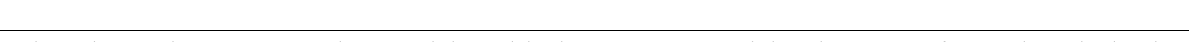
Fig. 1 Advanced maternal age impacts on embryonic and placental development. a Gross morphological appearance of E11.5 embryos developed in young (8 – 12 weeks old) and aged (42 – 54 weeks old) C57BL/6 females. Each row depicts one entire litter. Scale bars : 1 mm. b Histological analysis by H&E staining and by in situ hybridisation for the trophoblast giant cell marker Prl2c2 ( Plf ) of placentas associated with conceptuses developed in aged females. The top row depicts a normally developed embryo that is associated with a grossly normal placenta. The four rows below depict embryos with varying degrees of developmental retardation and morphological defects such as a failure of neural tube closure ( arrowhead ). The placentas associated with these embryos are also defective, insofar as the trophoblast portion is severely under-developed (the dotted line indicates the boundary between the fetal trophoblast compartment and the maternal decidua) or the main direction of placentation is off-centre (arrow). Scale bars : 1 mm. c RT-qPCR analysis of placentas developed in young control ( “ Y ” , n = 3) and aged ( “ A ” ) females. Conceptuses developed in aged females were divided into those that appeared grossly normal ( “ An ” ; n = 6) or abnormal ( “ Aa ” ; n = 6). Markers used represent trophoblast stem cell genes Eomes and Esrrb , markers of the so-called intermediate trophoblast (as found in the ectoplacental cone) or spongiotrophoblast (SpTr) Tpbpa and trophoblast giant cells Prl2c2 , and placental labyrinth expressed genes Synb and Ctsq . Data are displayed as mean ± S.E.M. * p < 0.05; ** p < 0.01; *** p < 0.001 (ANOVA with Holm-Bonferroni ’ s post-hoc test). d Diagram of the main trophoblast differentiation defects frequently observed in aged females. Green shading indicates compartments that are relatively over-represented, whereas red shading depicts major differentiation routes that are missing or under-represented. Genes listed in the representative